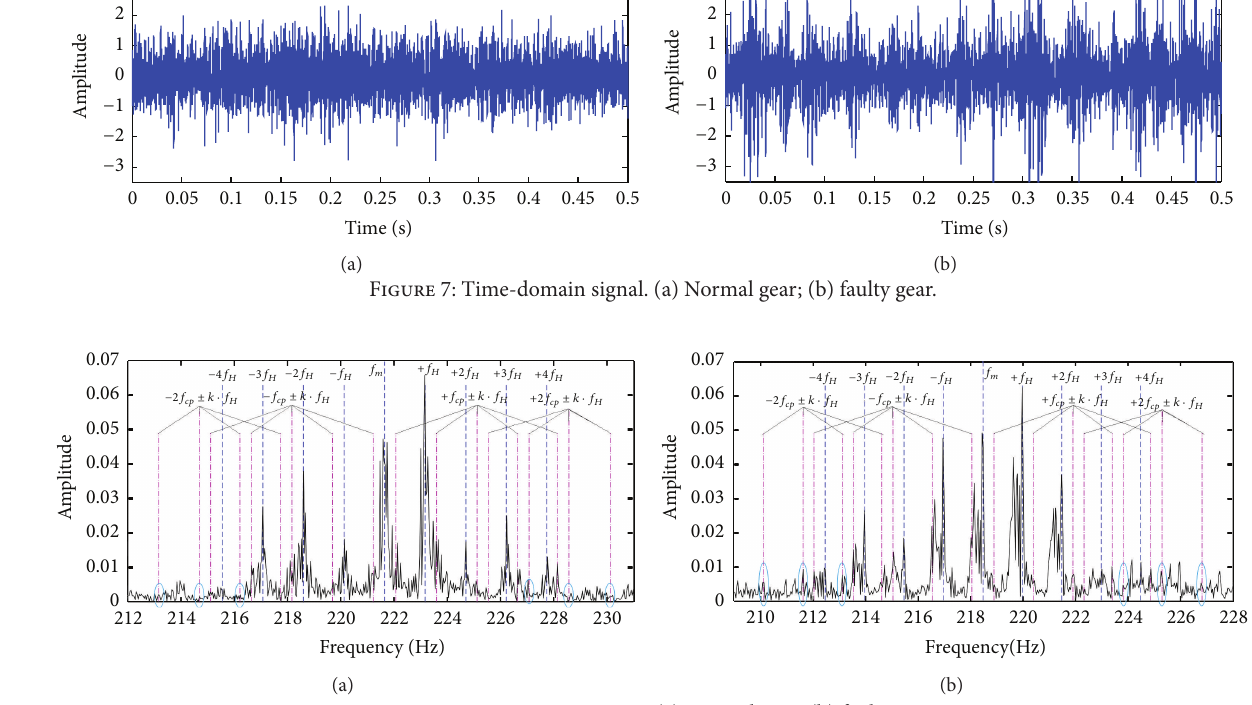
Figure 8: Frequency spectrum. (a) Normal gear; (b) faulty